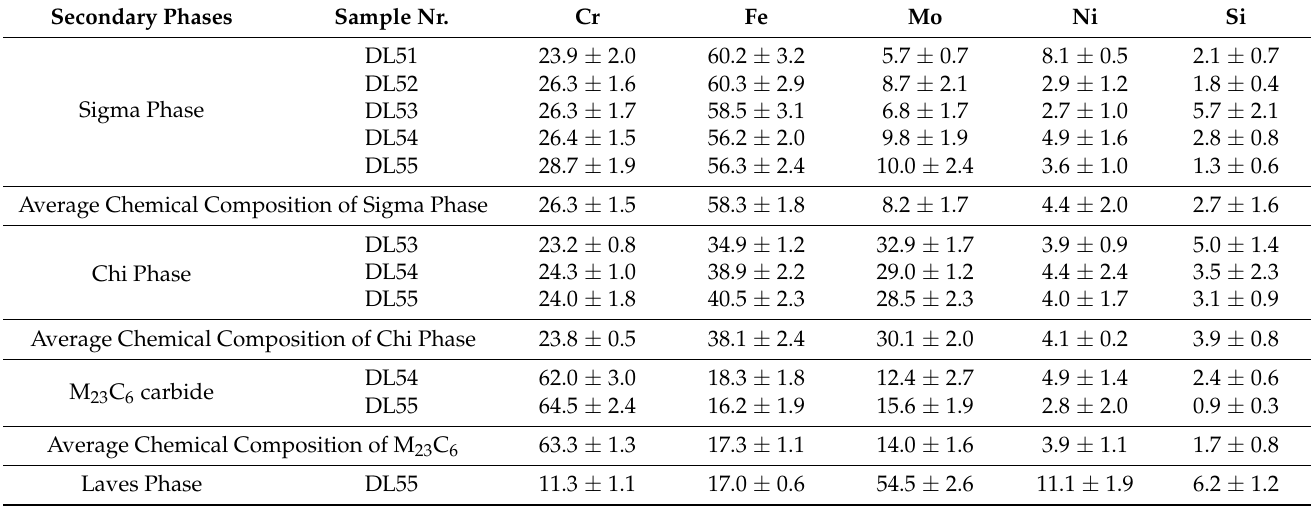
Table 5. Chemical compositions of identified secondary phases in AISI 316L (40% CW) with condi- tions provided in Table 4.